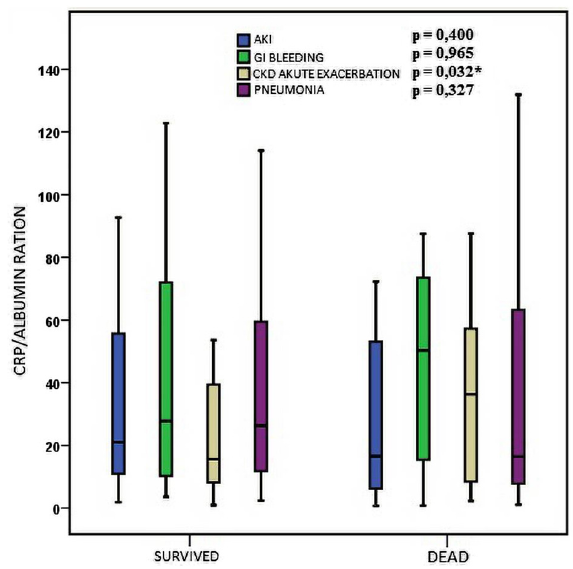
Figure2: CRP/Albdistributionaccordingtosurvivalamongpatients admitted to the ICU for the four most common reasons.